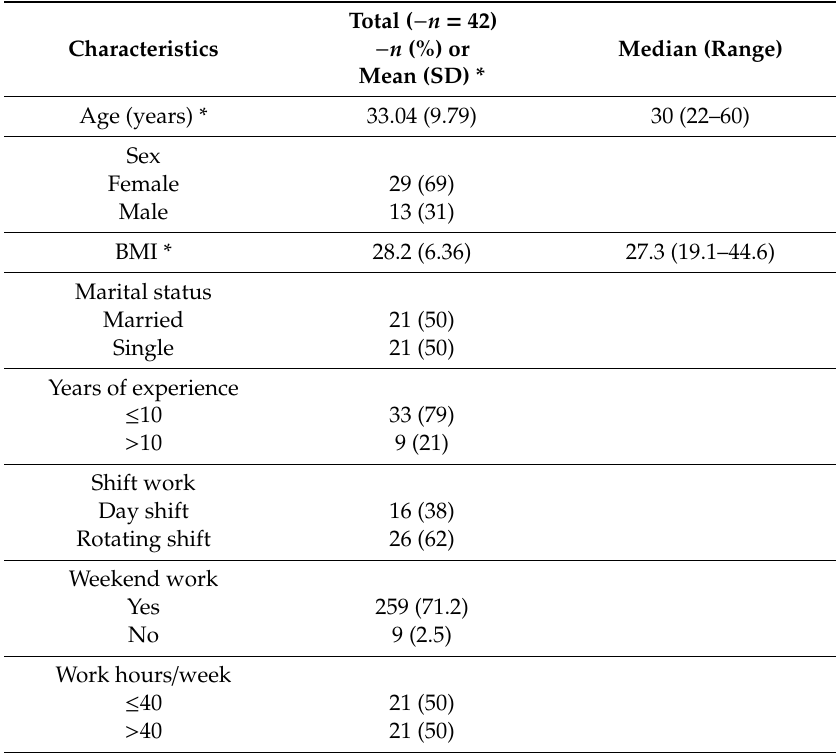
Table 1. Descriptive statistics of the study participants.